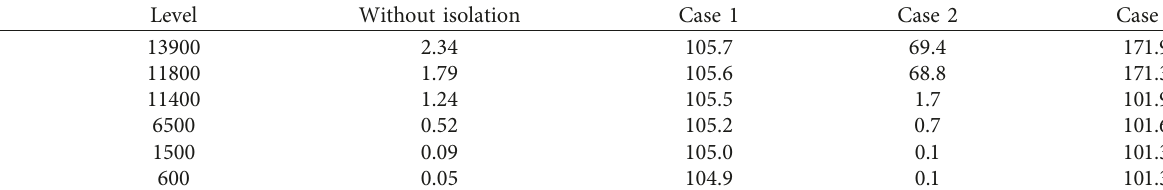
Figure 12: Acceleration time history. (a) No. 1, (b) no. 2, (c) no. 3, (d) no. 4, (e) no. 5, (f) no. 6, (g) no. 7. Table 8: Average maximum displacement under design-based earthquake (mm).